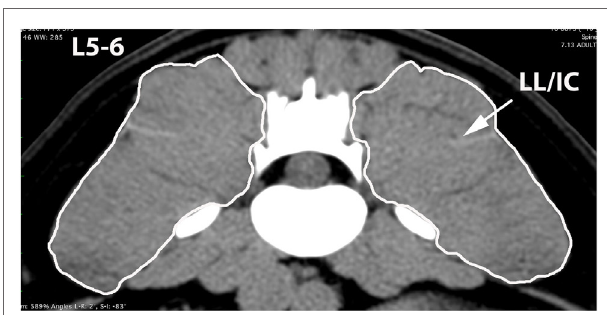
FIGURe 7 | transverse Ct image at the level of L5–6, illustrating margins of the combined longissimus lumborum/iliocostalis (LL/IC) muscle group .